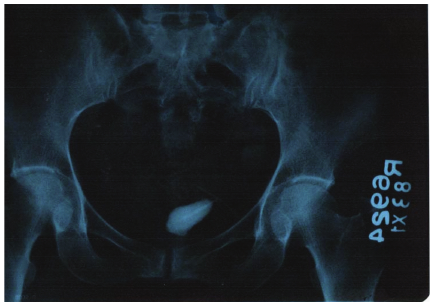
Figure 1: Plain X-ray showing the calculus and the horizontal limb of the device attached to it.